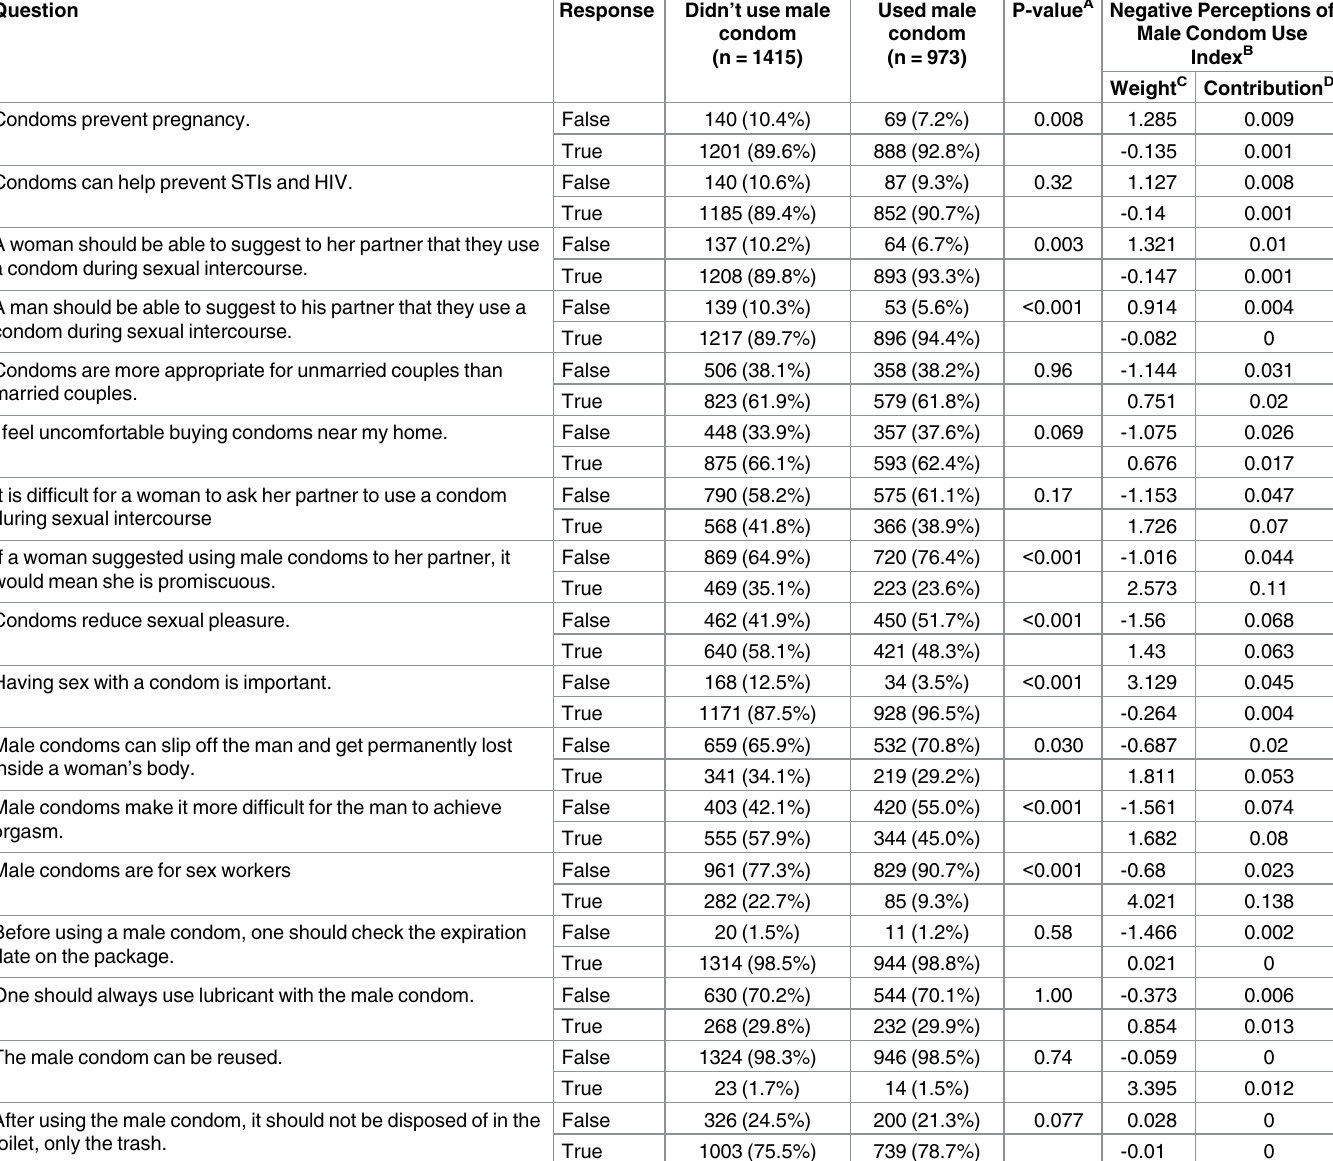
Table 2. Tabulation of 15 true or false questions regarding male condom non-use and the relative weight and contribution of each to the negative perceptions index.